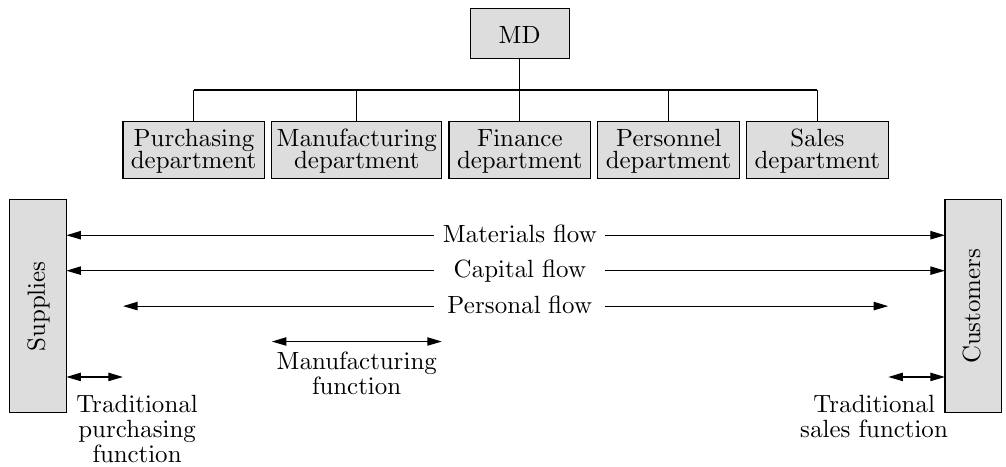
Figure 2: Flows and processes are cutting across traditional department boundaries (Ericsson